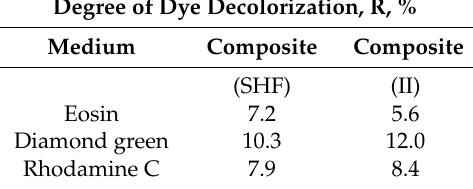
Table 5. Degree of extraction (R, %) of water-soluble dyes (eosin, diamond green, rhodamine C) with participation of composites from water media. The determination error is 3–5%. Contact time is 6